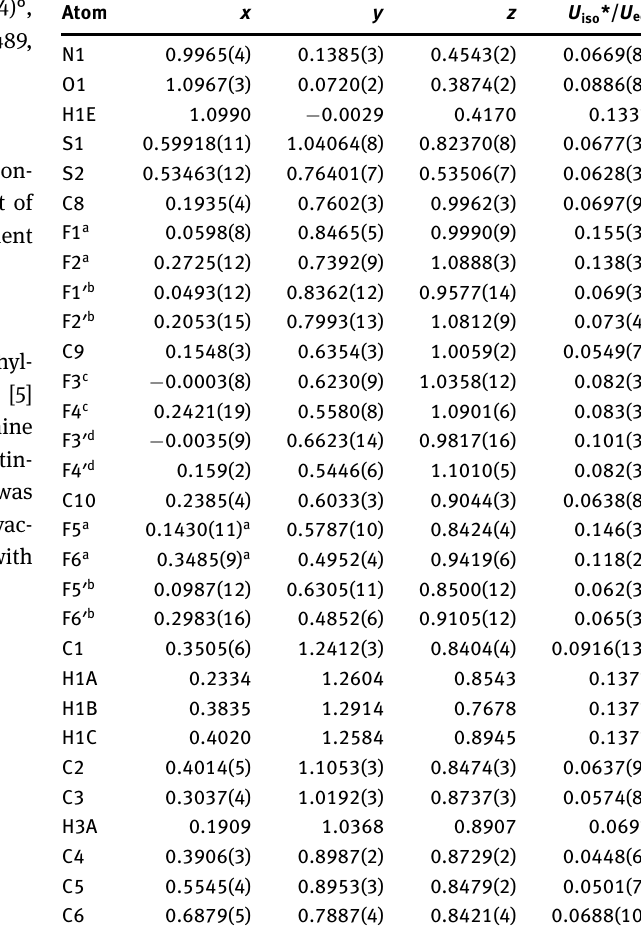
Table 2: Fractional atomic coordinates and isotropic or